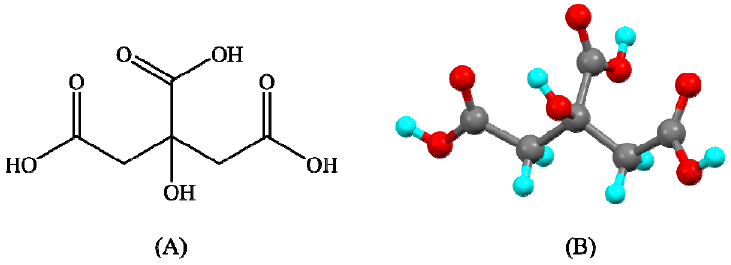
Figure 19. Chemical structure of oxalic acid ( A ) 2d and ( B ) 3d.